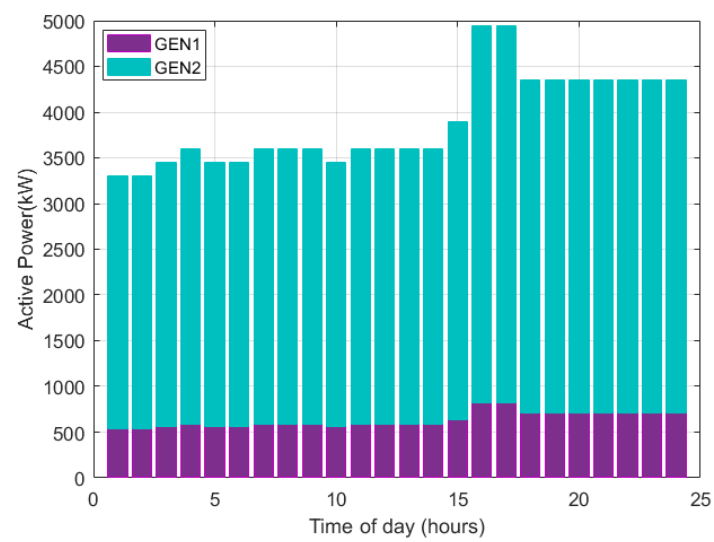
Figure 13. Power produced by auxiliary diesel generators (optimization level 1). The total active power of the PEV parking lot, together with its respective upper and lower limits, is shown in Figure 14. Generator convention was used, hence the negative values indicate that the aggregate battery absorbed power from the grid (i.e., it was charging), while positive values indicate that the battery injected power to the grid (i.e., it was discharging). The total energy that was stored in the equivalent aggregate battery of the microgrid’s parking lot, as well as its respective upper and the lower limits, is shown in Figure 15. These limits changed over time as a result of the fluctuating number of connected EVs and electricity price variations. The algorithm effectively covered the microgrid’s energy demand with internal power sources during its autonomous operation and, at the same time, it reduced its daily operational cost. It was observed that all of the PEVs managed to reach their energy targets while satisfying all of the operational